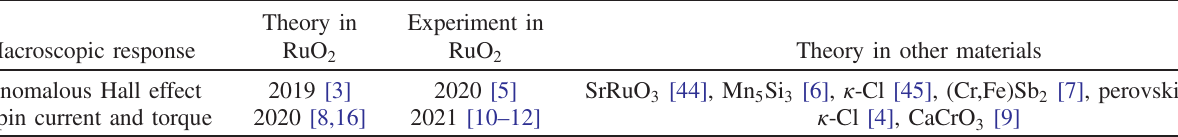
TABLE I. Theoretical predictions, supported by experiments, of T -symmetry breaking macroscopic phenomena in RuO 2 , and a list of other altermagnetic materials in which these macroscopic responses were also theoretically predicted. The anomalous Hall effect is a T -odd off-diagonal component of the electrical conductivity tensor [2]. The T -odd spin current can be generated along or transverse to an applied electrical bias; an out-of-plane spin current generated by an in-plane electrical bias in an altermagnetic layer can exert a torque on magnetic moments in an adjacent layer in a multilayer stack